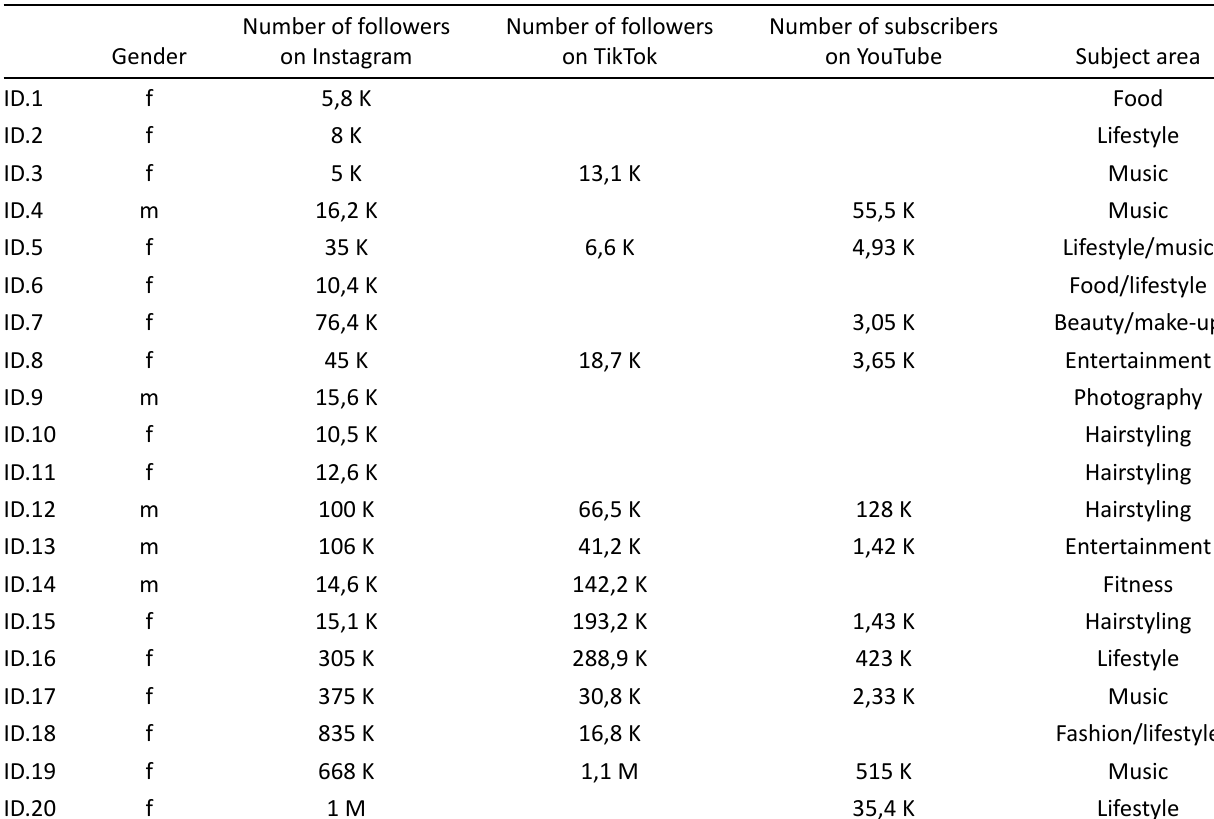
Table 1. Description of the